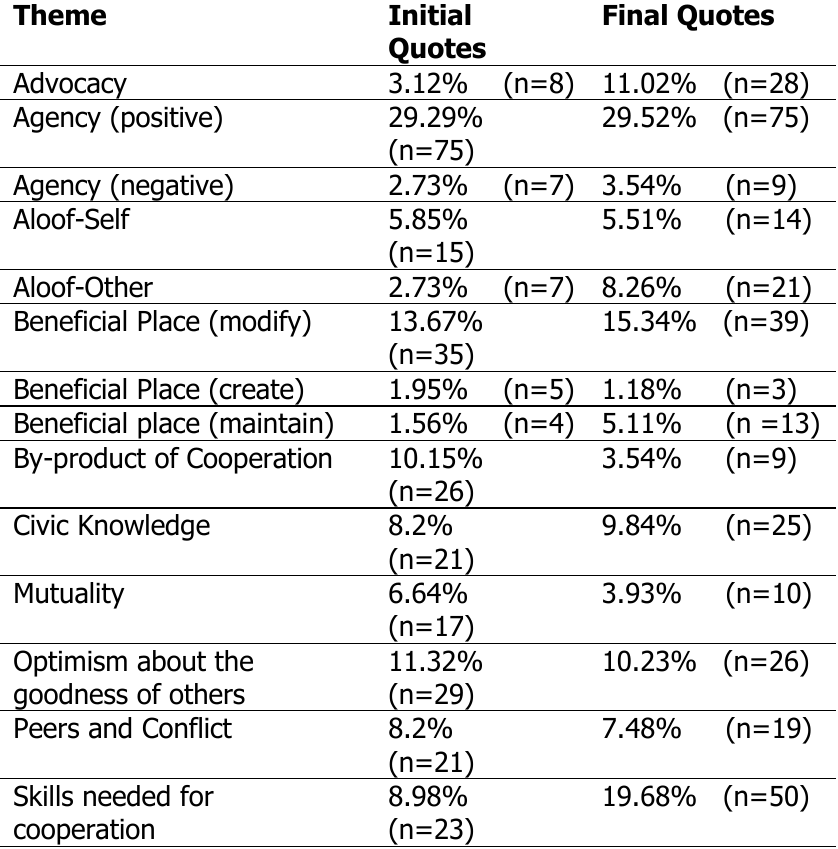
Comparison of percentage of quotes for each theme at initial and final focus